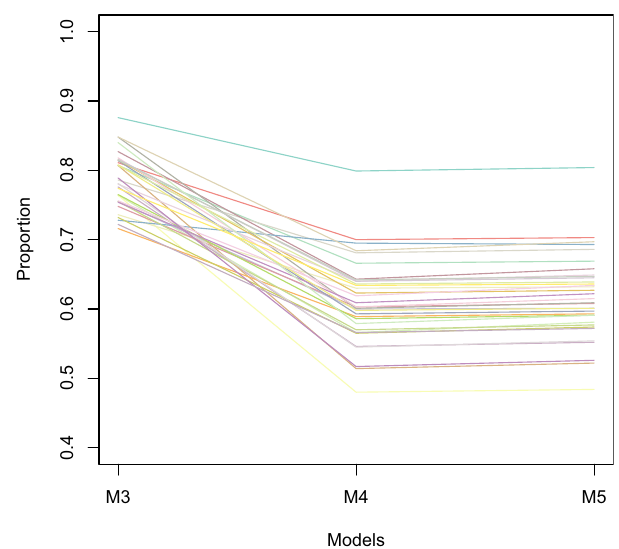
Fig. 3 Residual variance estimates in PISA data across IRT-LRMs (M3, M4,